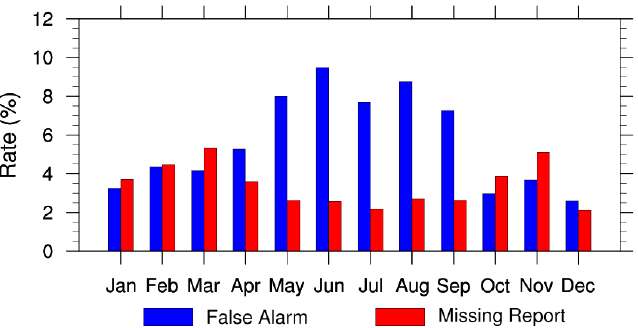
Figure 3. The false alarm rate (FAR) and missing report rate (MRR) of the AE_Rain rainfall in 2004 using the in-situ measurements of rainfall data [36] as reference.